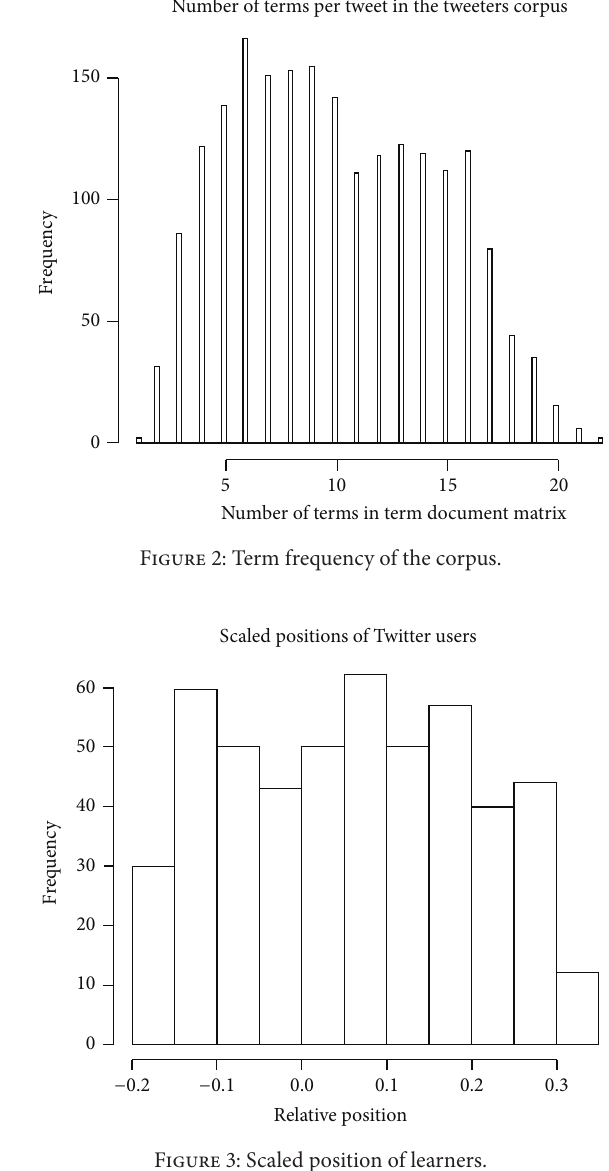
Figure 3: Scaled position of